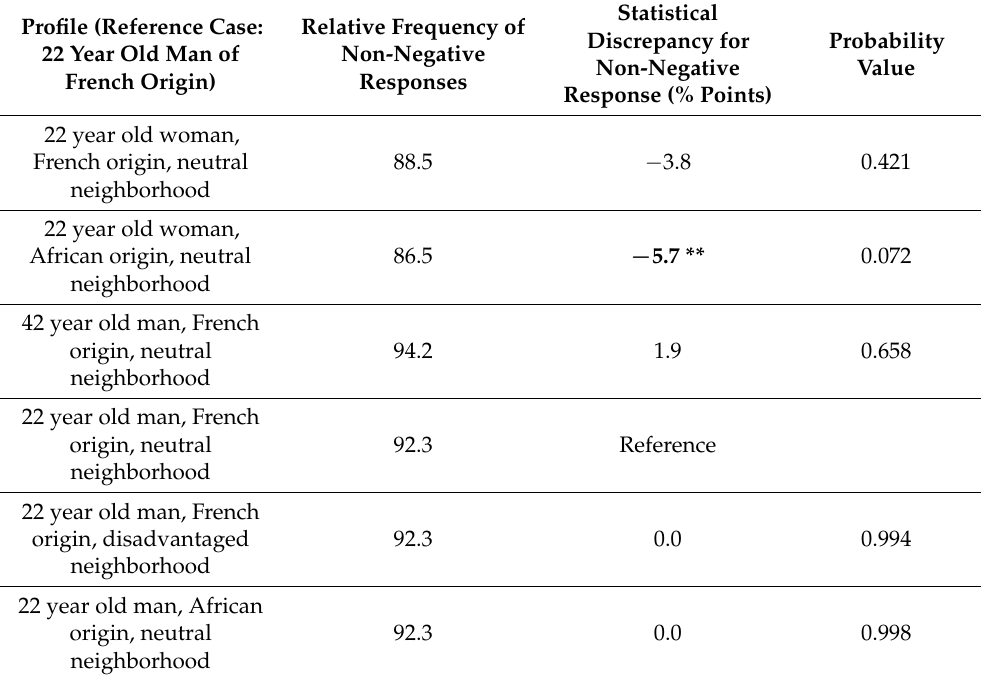
Table 6. Differences in the non-negative response rate relating to supplemental health insurance applications (reference profile: 22 year old man, French